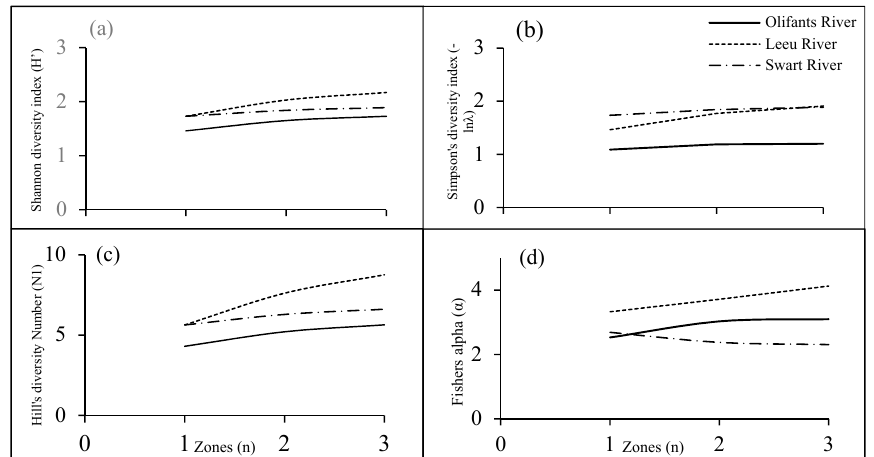
Figure 3. Species diversity curves for Olifants (solid line), Leeu (dotted line) and Swart (solid-dotted line) rivers in Western Cape, South Africa. ( a ) The Shannon diversity index curves with the riparian zone has the highest index, ( b ) the Simpson’s diversity index curves with the Leeu River and Swart riparian zones plateau at the same highest value ( c ) Hill’s diversity number curves show the Leeu riparian zone to have the highest diversity value and ( d ) the Fisher’s alpha index is the highest for the Leeu riparian zone with the Swart River Fisher’s alpha value decreasing away from the river bank. Species diversity indices increased towards the zone furthest from the waterpoint.